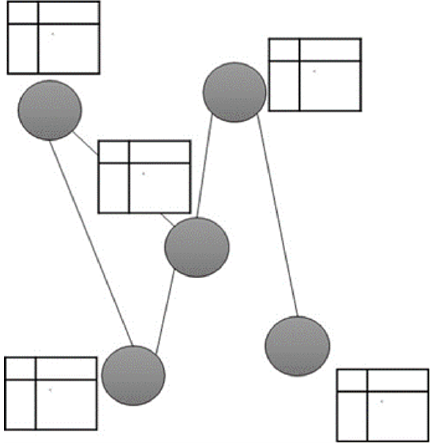
Figure 1. General structure of a Bayesian